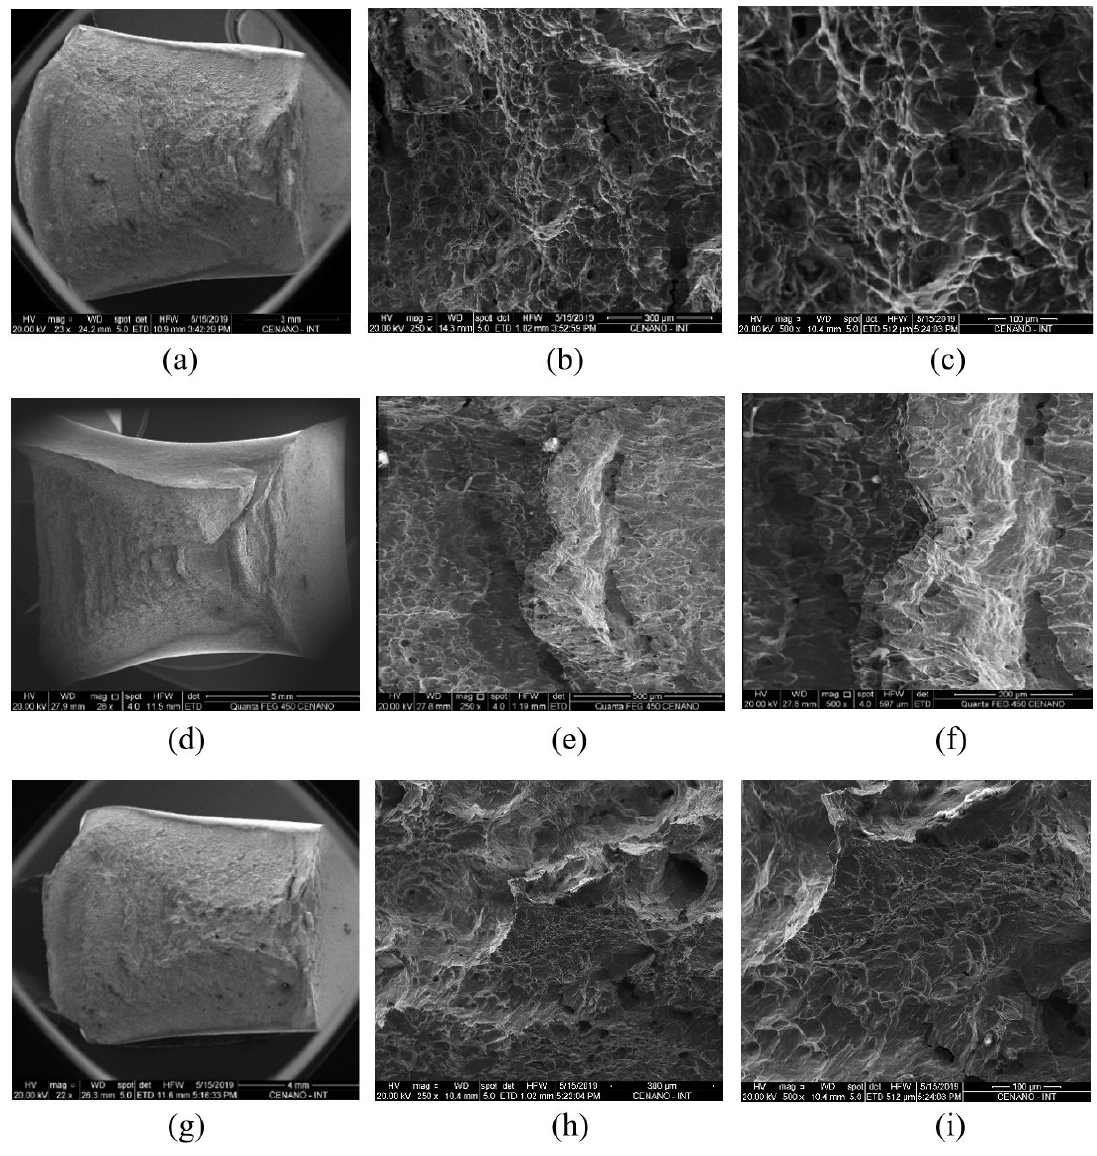
Figure 8. SEM micrographs showing the fracture surface morphology after Charpy impact testing at - 46°C: (a), (b) and (c) AR-CW (A); (d), (e) and (f) ST-1100 (B); (g), (h) and (i) ST-1150